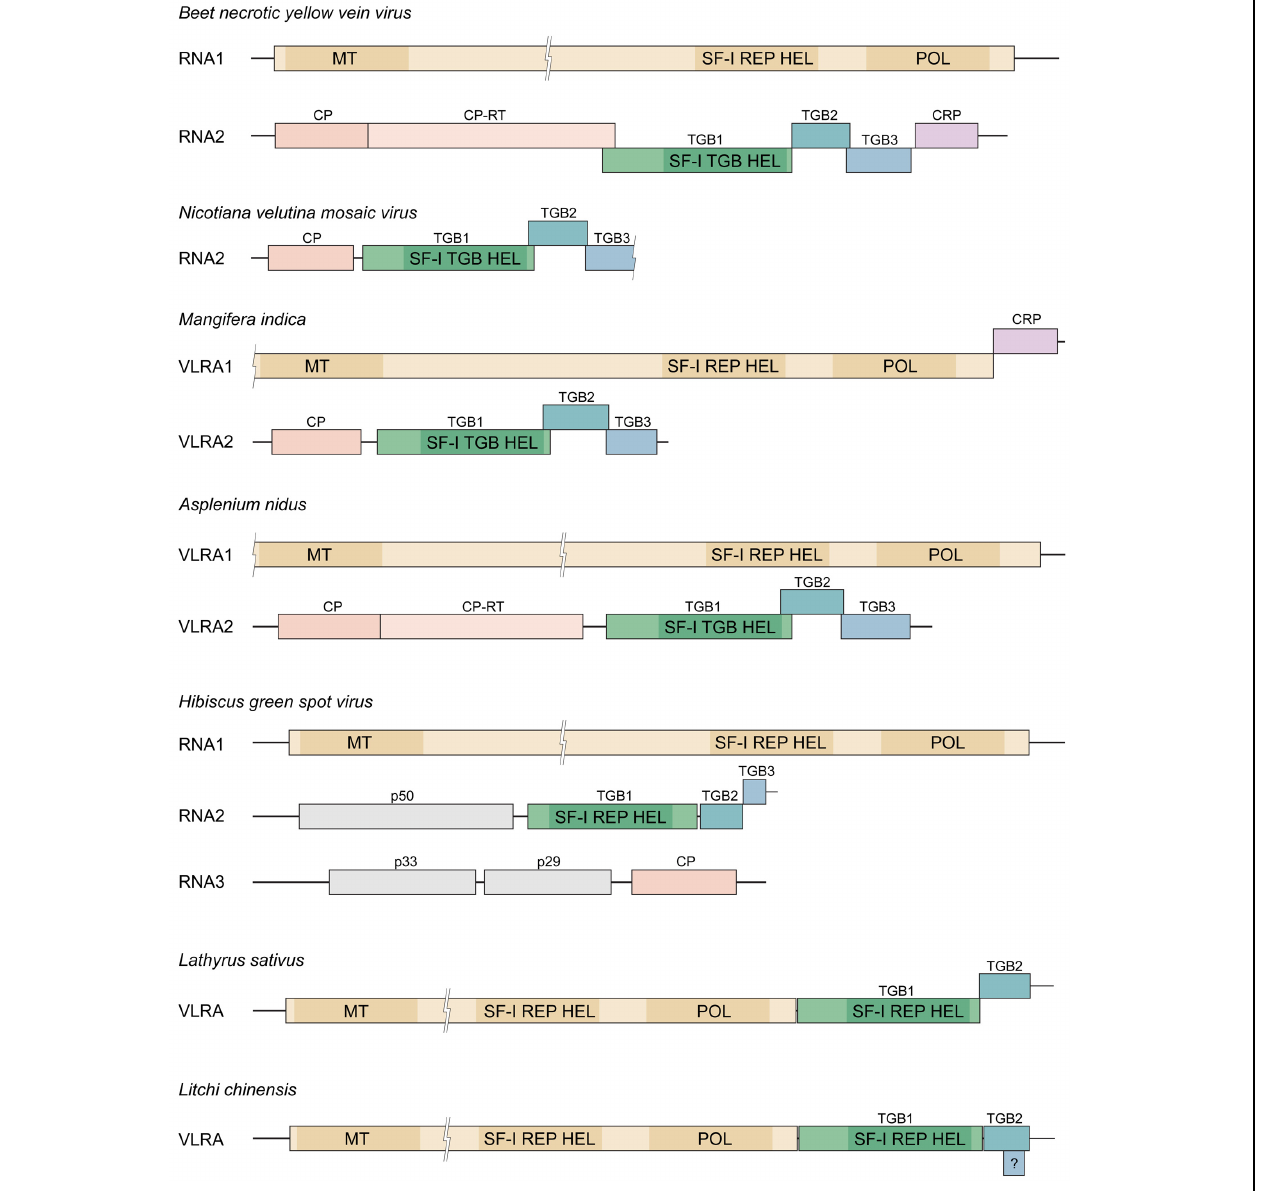
in replicative proteins are not shown. “SF-I REP HEL” denotes the superfamily I helicase domain typical for replicase proteins, “SF-I TGB HEL” – the superfamily I helicase domain typical for TGB1 proteins. CP, coat protein gene; CP-RT, readthrough domain of CPs; CRP, genes of cysteine-rich proteins. “?” indicates the short open reading frame (ORF) in Lc-VLRA potentially representing TGB3